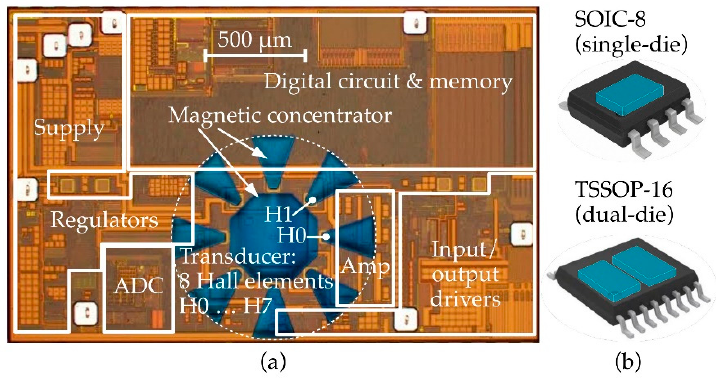
Figure 2. ( a ) Optical micrograph of the sensor microsystem implemented in a standard 0.18 μ m CMOS technology. The eight circularly arranged horizontal Hall elements are complemented with an accurately structured 23- μ m-thin magnetic concentrator [5] in order to exploit the in-plane magnetic field components. The integrated circuitry is discussed in-depth in [6]. ( b ) assemblies into SOIC-8 and TSSOP-16 molded plastic packages for the single-die and redundant, side-by-side dual die versions, respectively.